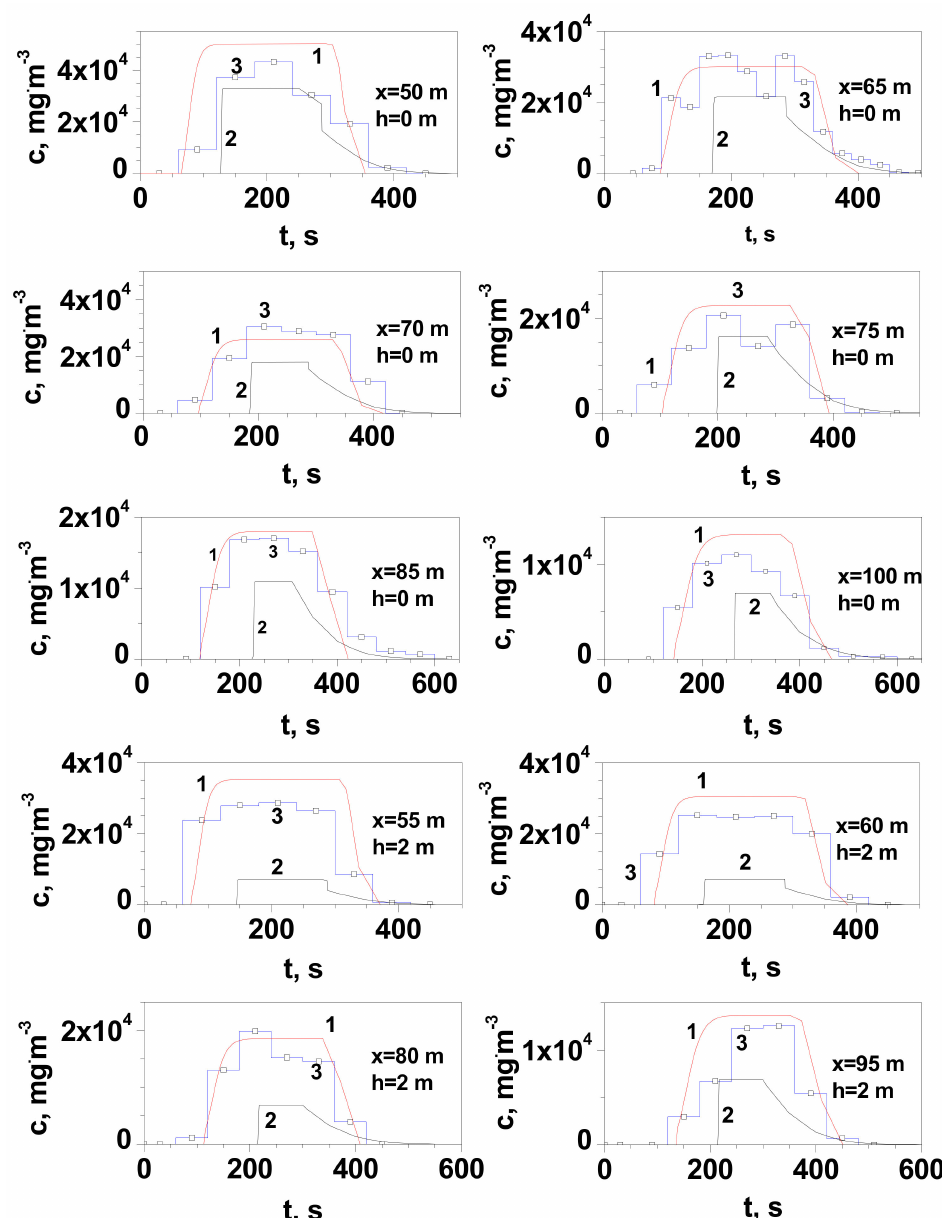
Figure 7. Comparison of the concentration dependence as a function of time for the Gaussian gas model ( 1 ) and the dense gas model ( 2 ) against the obtained experimental data ( 3 ) at height (h) and at distance (x) from the release location in the wind blowing direction. Atmospheric conditions of the measurement series 4: T = 20.7 ◦ C, v = 0.57 m/s, RH = 53%, p = 1002.8 hPa. Release parameters: Q = 1.78 kg/s, p out = 6.1 atm, t = 243 s, h = 0.75